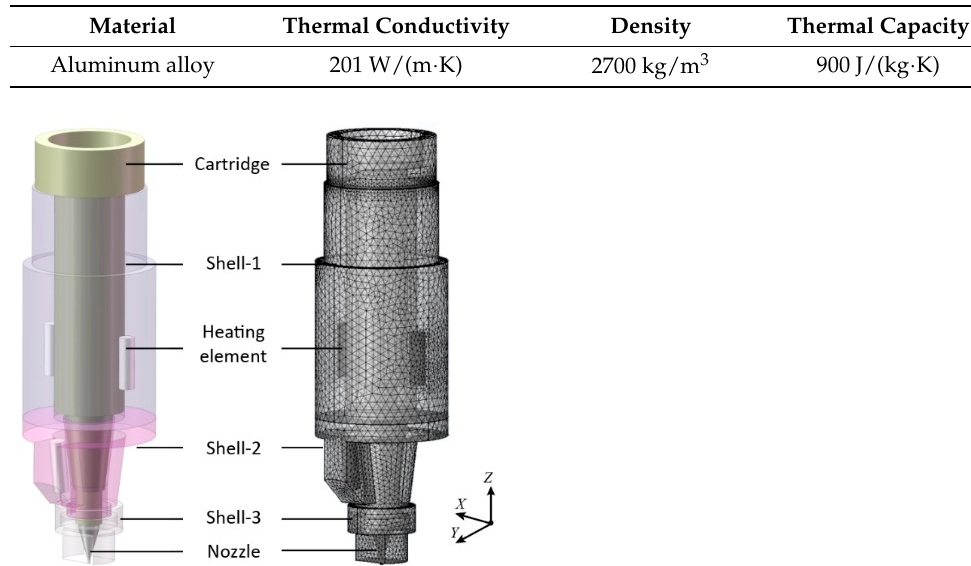
Table 1. Parameters selected for the simulation.